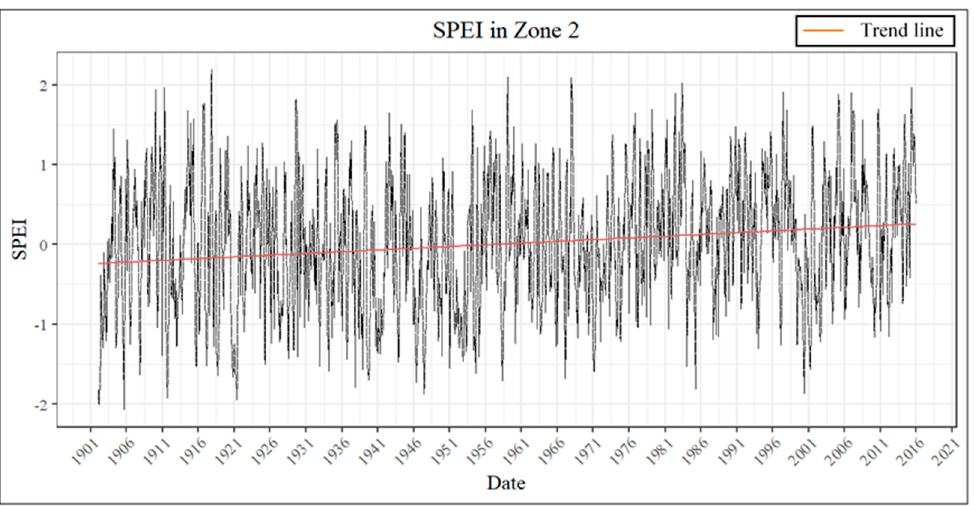
Figure 10. Three-month SPEI from 1902–2015 for zone 1.